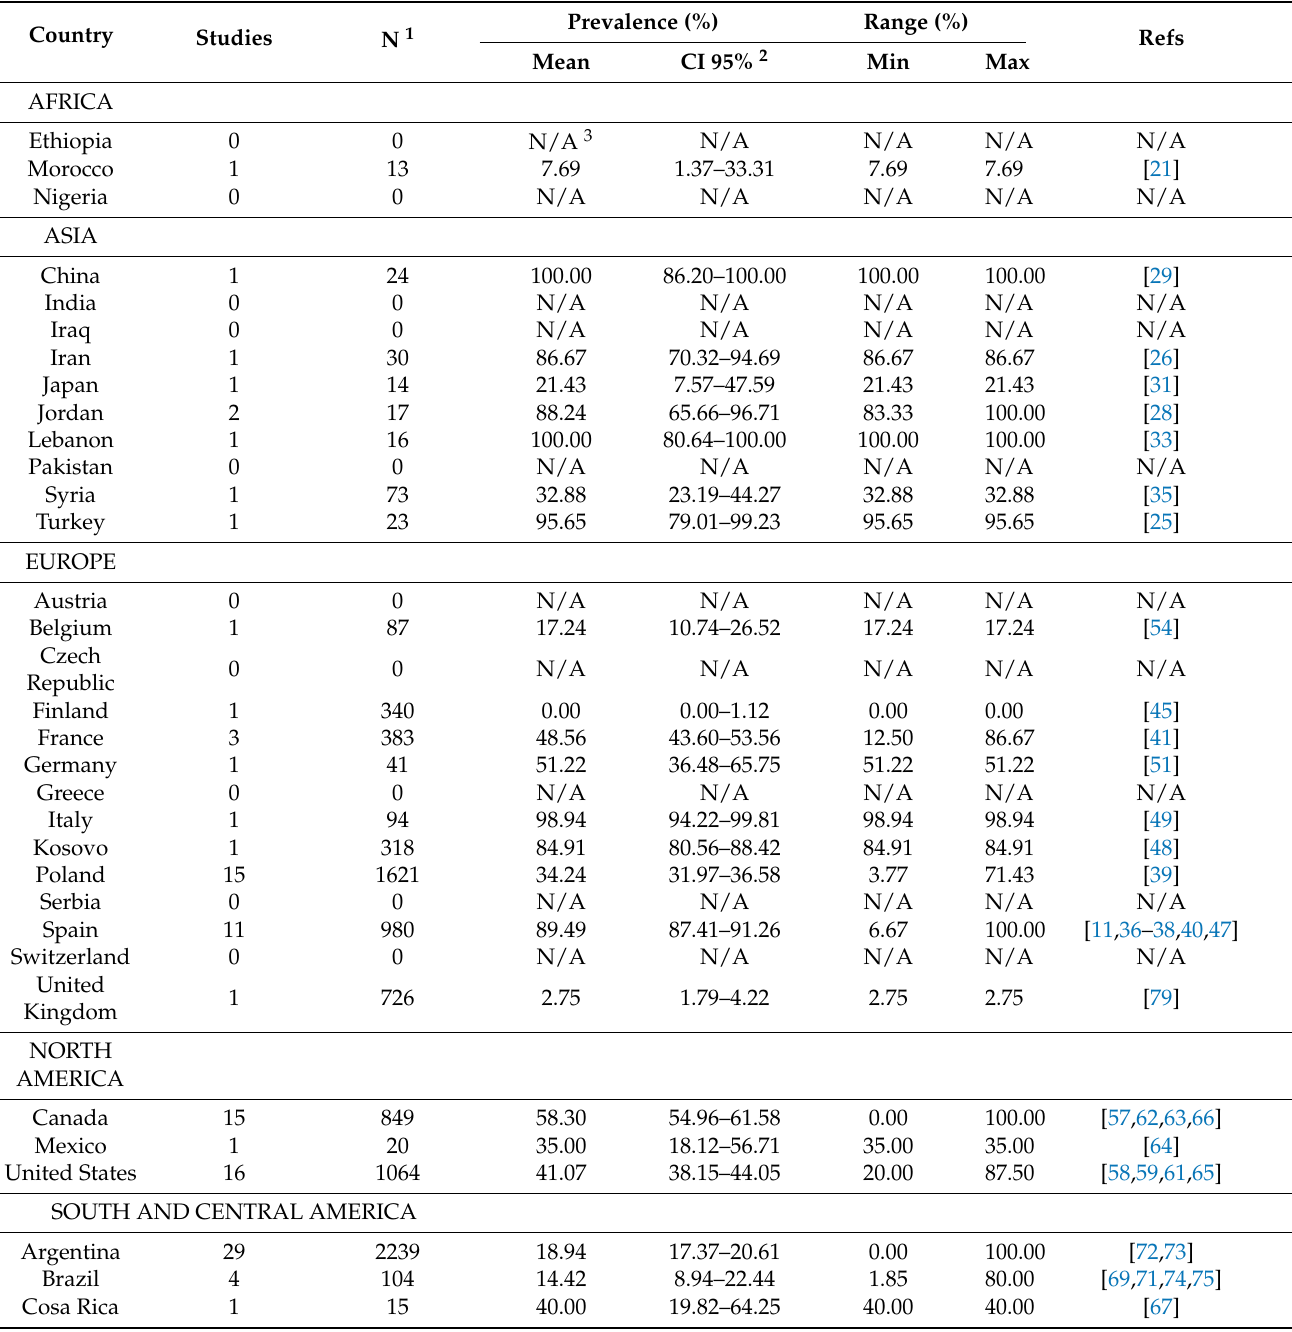
Table A10. Flock SRLV prevalence in each country. Mean, 95% confidence interval, and range are provided. Data extracted from scientific literature published from 1981 to